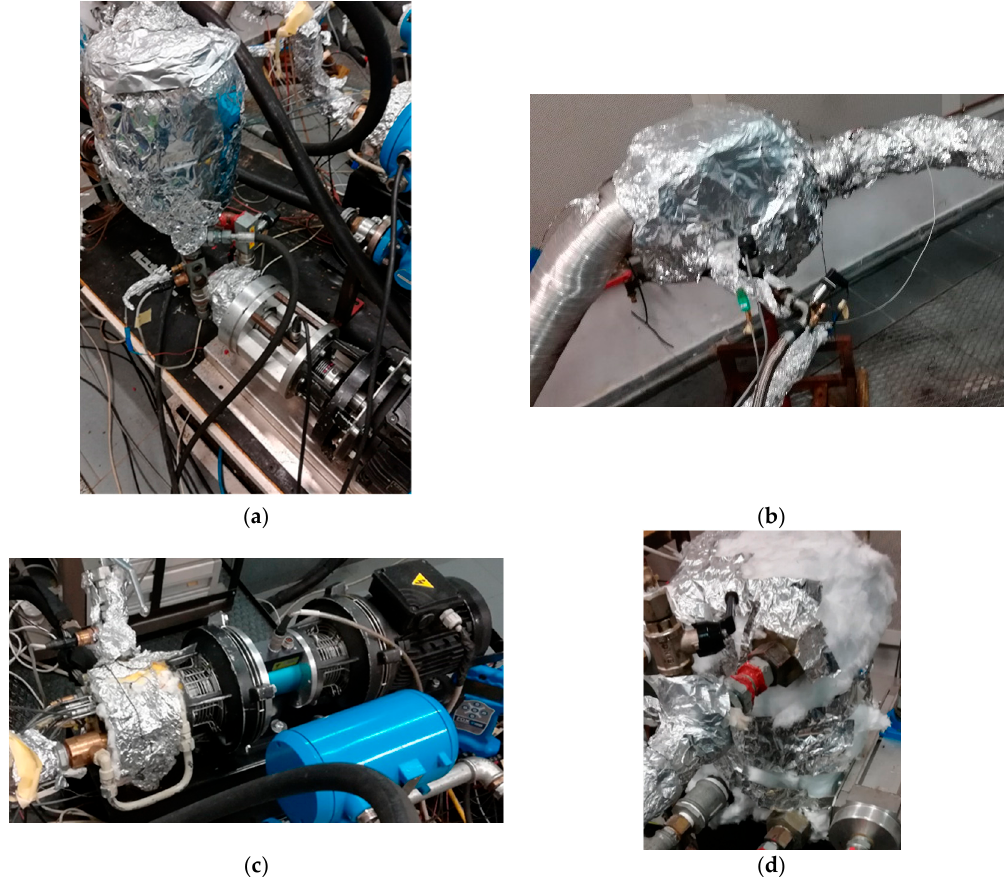
Figure 4. ( a ) Pump and upstream plenum; ( b ) heat recovery vapour generator (HRVG); ( c ) sliding vane rotary expander (SVRE); ( d ) plate heat exchanger (PHX) condenser.